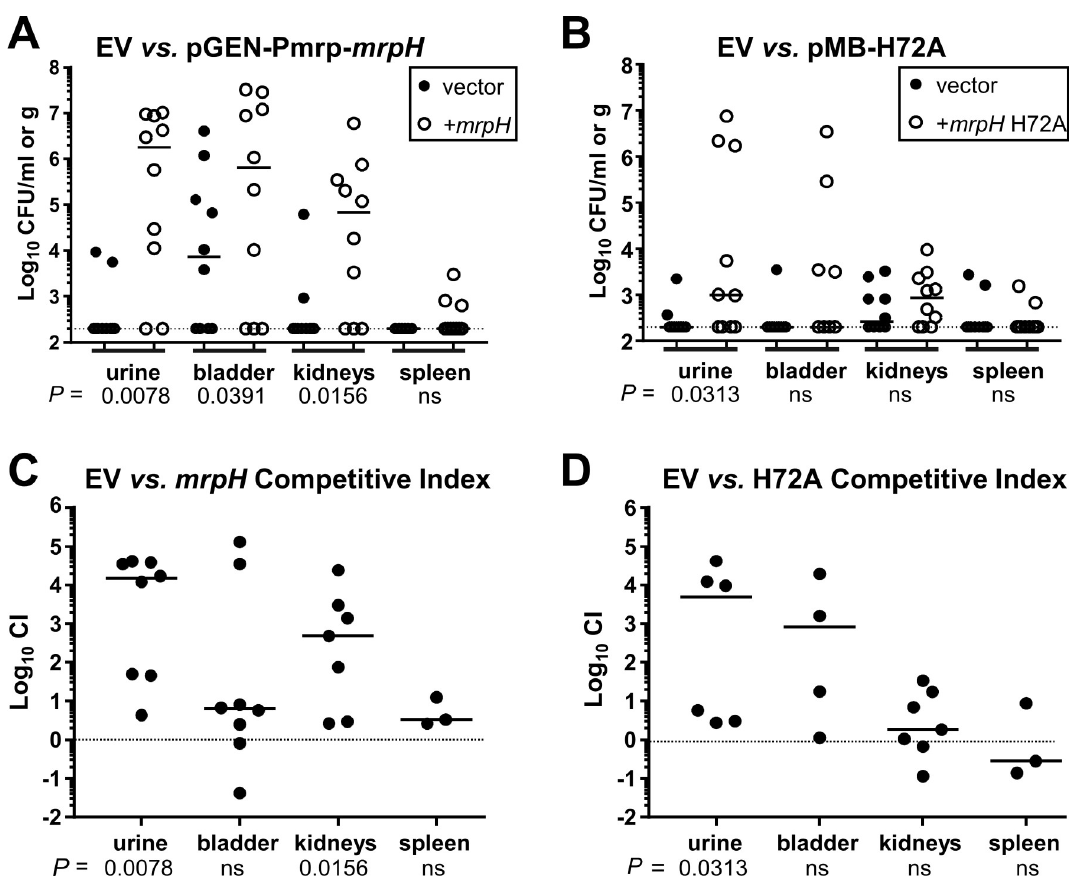
Fig 13. Zinc-coordinating residue H72 contributes to UTI. Bacterial recovery from female CBA/J mice at 7 dpi. P . mirabilis HI4320 mrpH Δ kan (kan S ) containing the empty vector pGEN-MCS (EV) was competed in a 1:1 ratio with HI4320 mrpH O kan (kan R ) containing either wild-type mrpH (pGEN-Pmrp- mrpH ) or mrpH H72A (pMB-H72A). (A and B) CFU recovery of P . mirabilis from urine or organs. Bar indicates median CFU. Limit of detection = 200 CFU, indicated with a dotted line. (C and D) Competitive indices (CI) of the experiments shown in A and B, showing the ratio of recovered (output) to input vector:complemented bacteria. The dotted line at y = 0 indicates no competitive advantage for either strain. Log CI > 0 indicates that the mrpH -complemented bacteria outcompeted the vector control. ns, not significant.